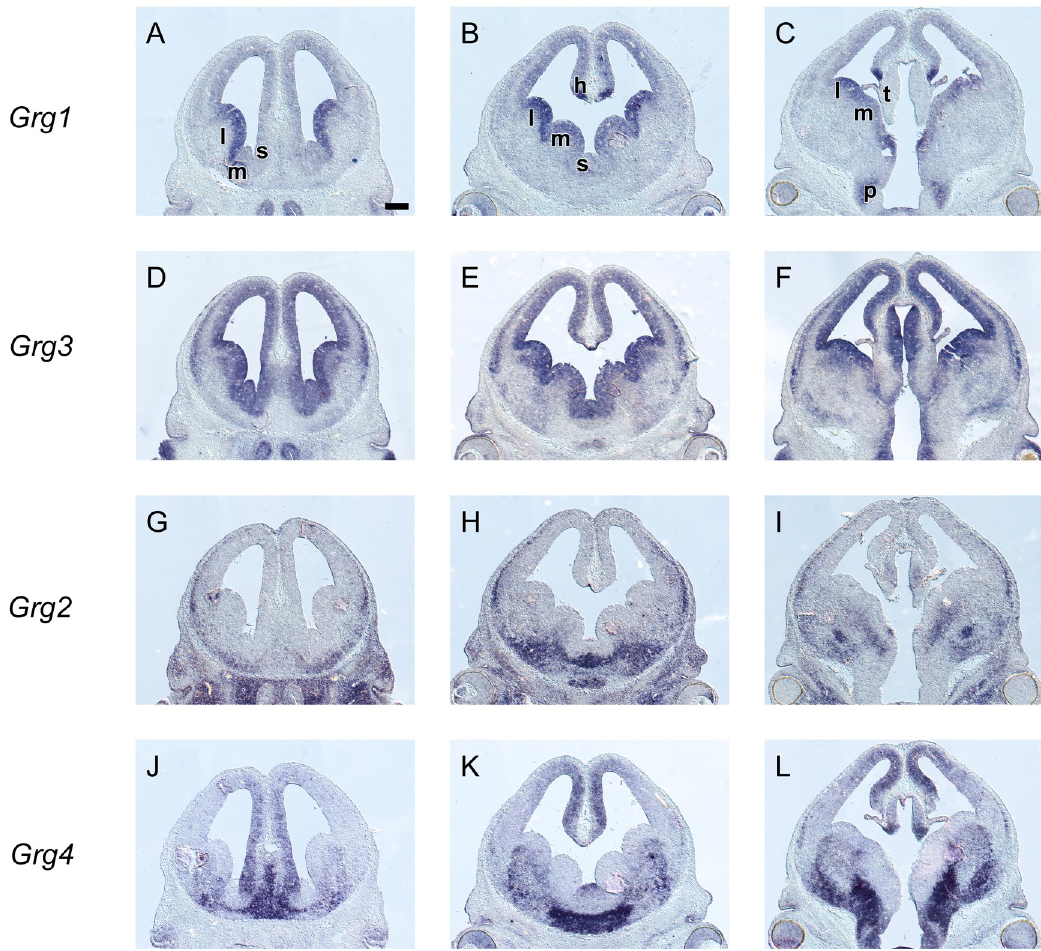
Fig 2. In situ hybridization on adjacent coronal sections through the embryonic telencephalon at E13.5 from rostral (left) to caudal (right) levels hybridized with an antisense RNA probe of Grg1 (A—C), Grg3 (D—F), Grg2 (G-I) and Grg4 (J—L) m: MGE, l: LGE, l: LGE, s: septum. Scale: 250 μ